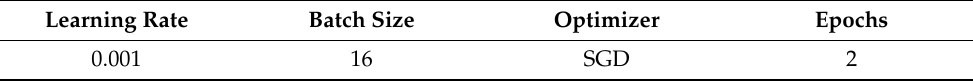
Table 5. Hyperparameters to train image classification networks using the NEU-DET dataset. Learning